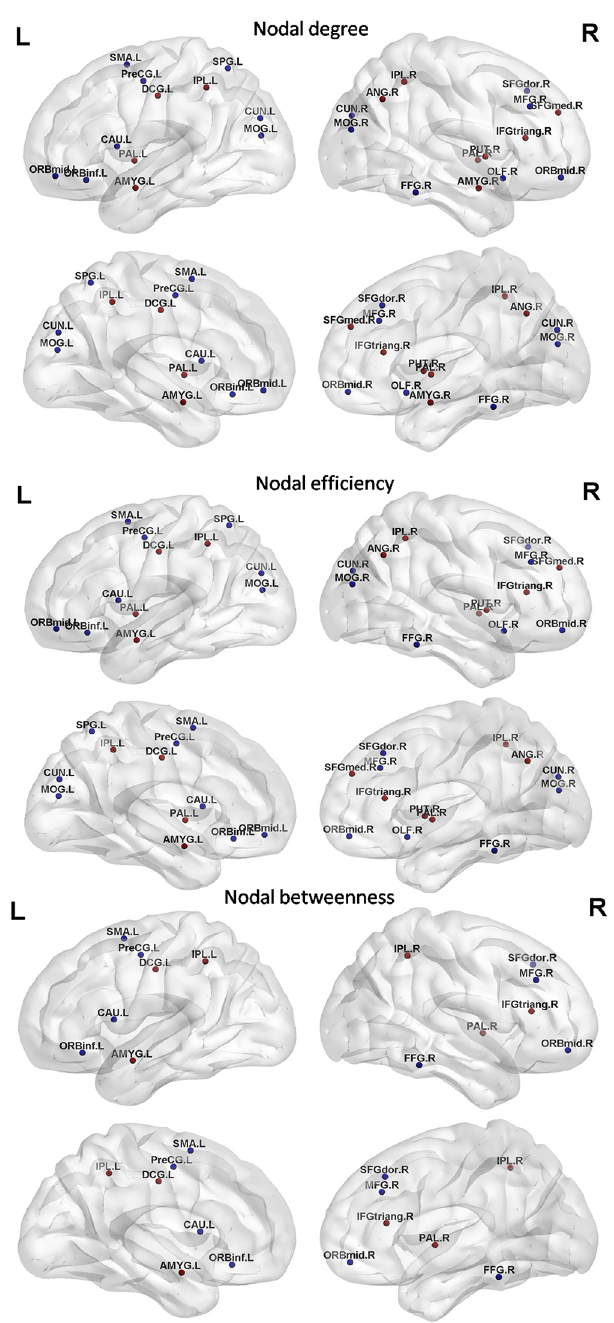
Fig 5. Brain regions showing significant alterations in nodal centrality between PD patients and normal controls (p < 0.05, uncorrected). The results were visualized using the BrainNet Viewer (NKLCNL, Beijing Normal University).Three-dimensional maps show the differences in nodal degree (top panel),nodal efficiency (middle panel),and nodal betweenness (bottom panel)between the PD group and the control group. Red/blue spheres denote regions of increased/decreased nodal centrality in PD patients. Detailed brain region information corresponding to the anatomical labels can be found in S1 Table.